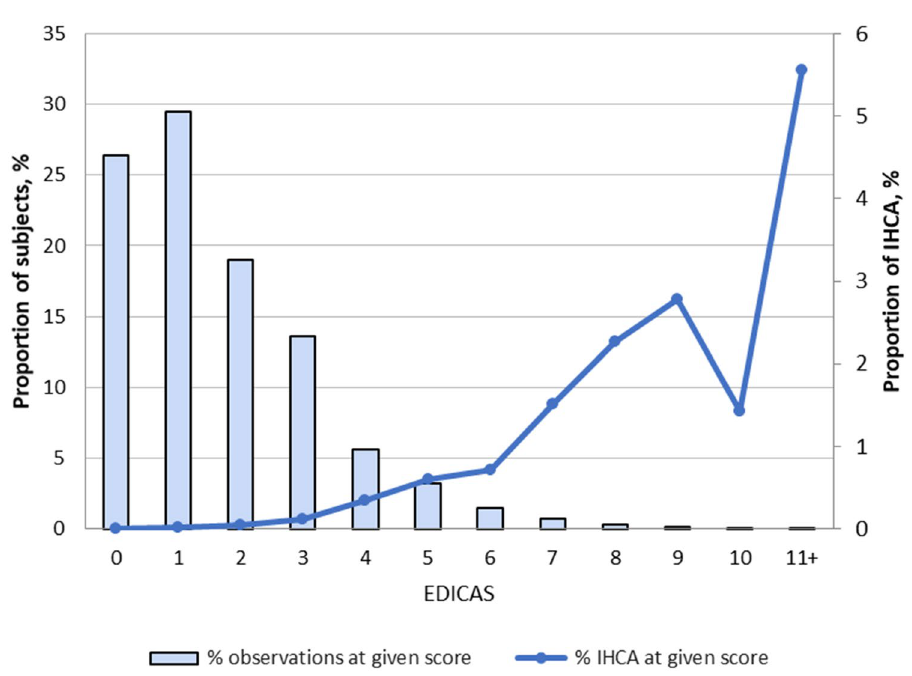
Figure 2. The distribution of EDICAS and proportion of IHCA in each EDICA category. EDICAS Emergency Department In-hospital Cardiac Arrest Score, IHCA in-hospital cardiac